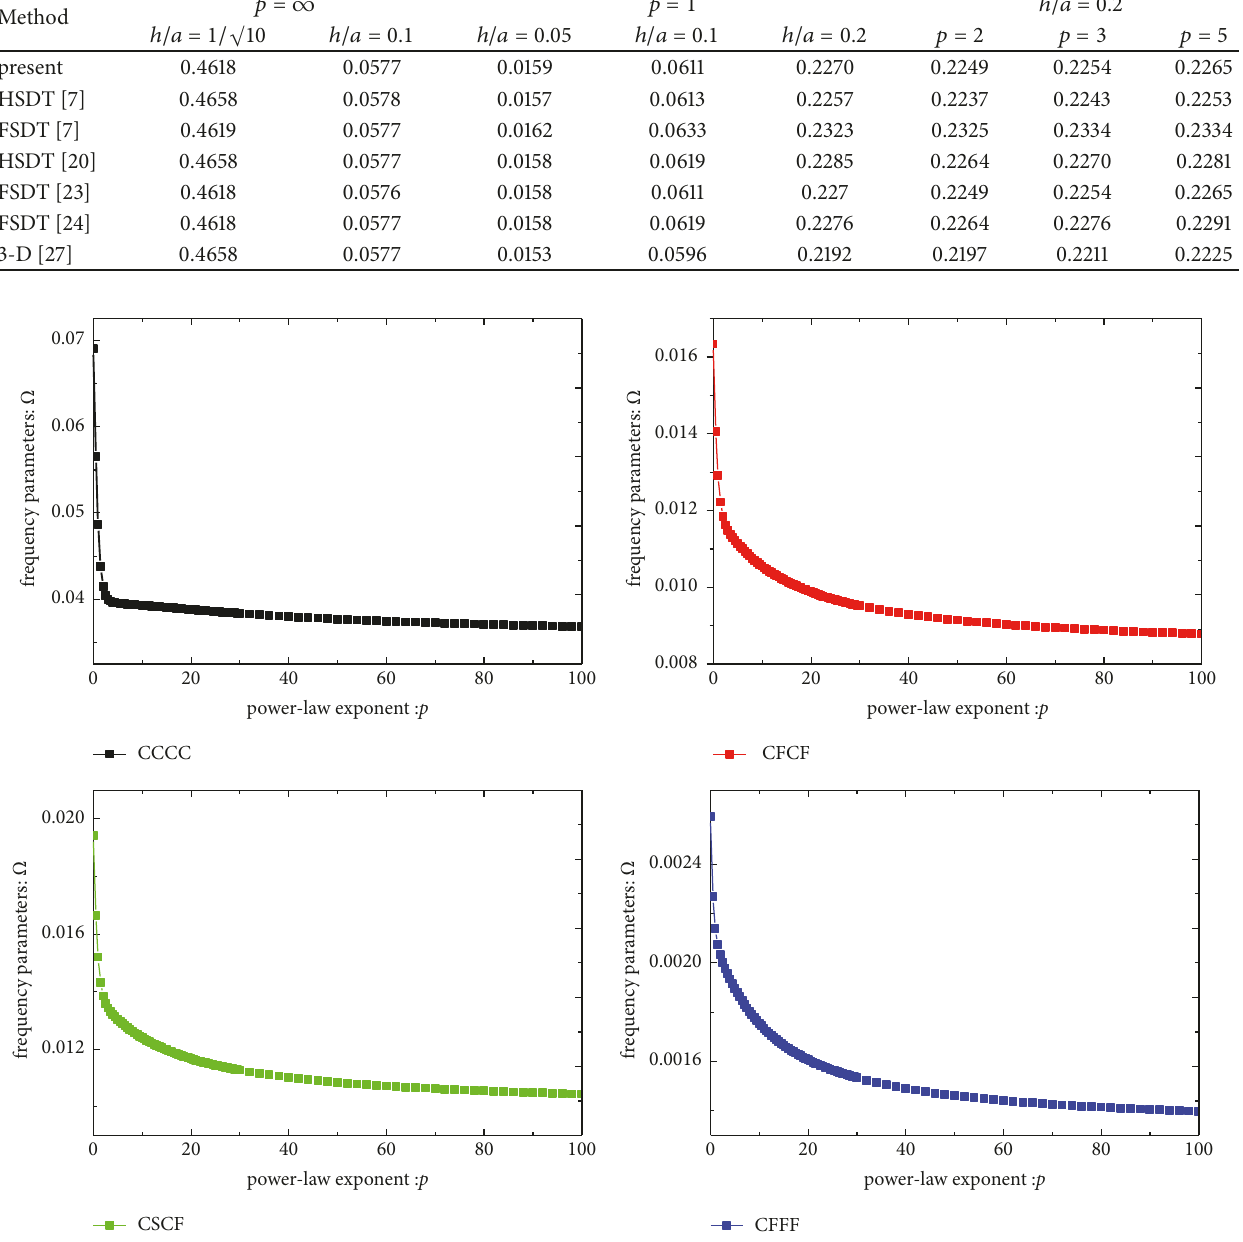
Figure 7: Variations of fundamental frequency parameter Ω versus the power-law exponent 𝑝 for Al/Al 2 O 3 rectangular plate with different boundary